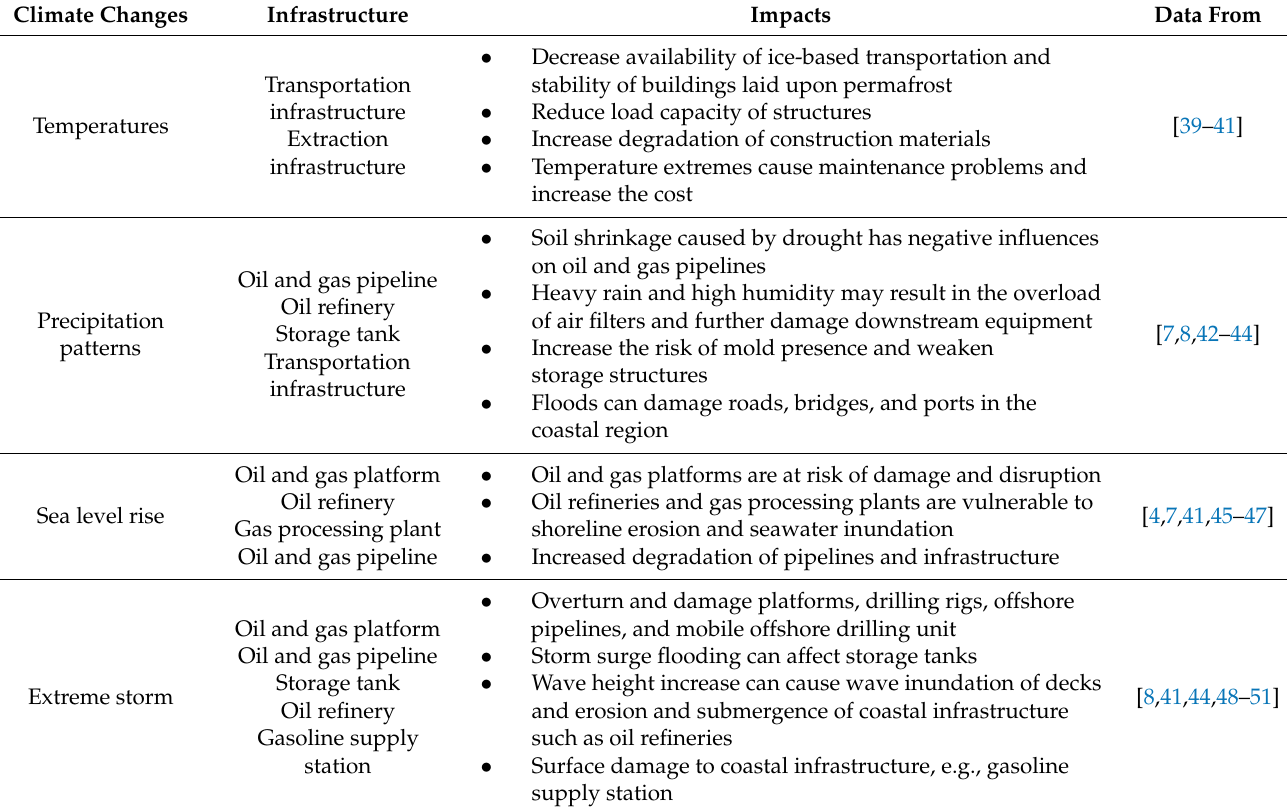
Table 1. Climate change impacts on coastal and offshore petroleum